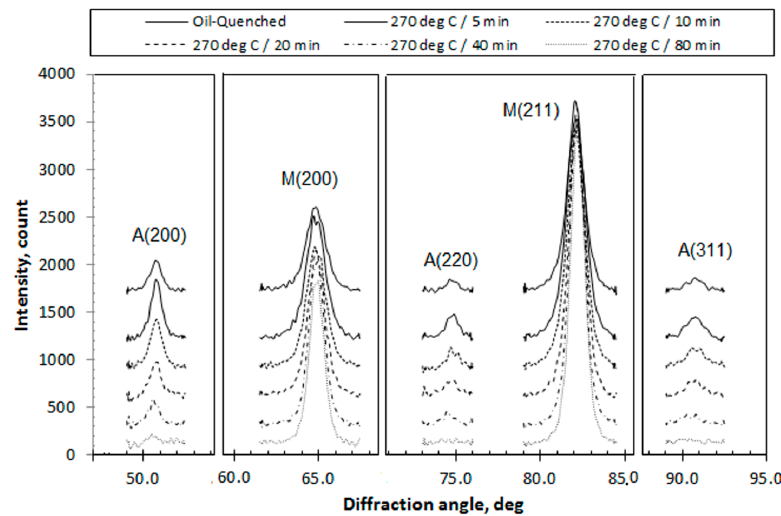
Figure 6. X-ray diffraction (XRD) peaks of the retained austenite and martensitic/bainitic ferrite phases.